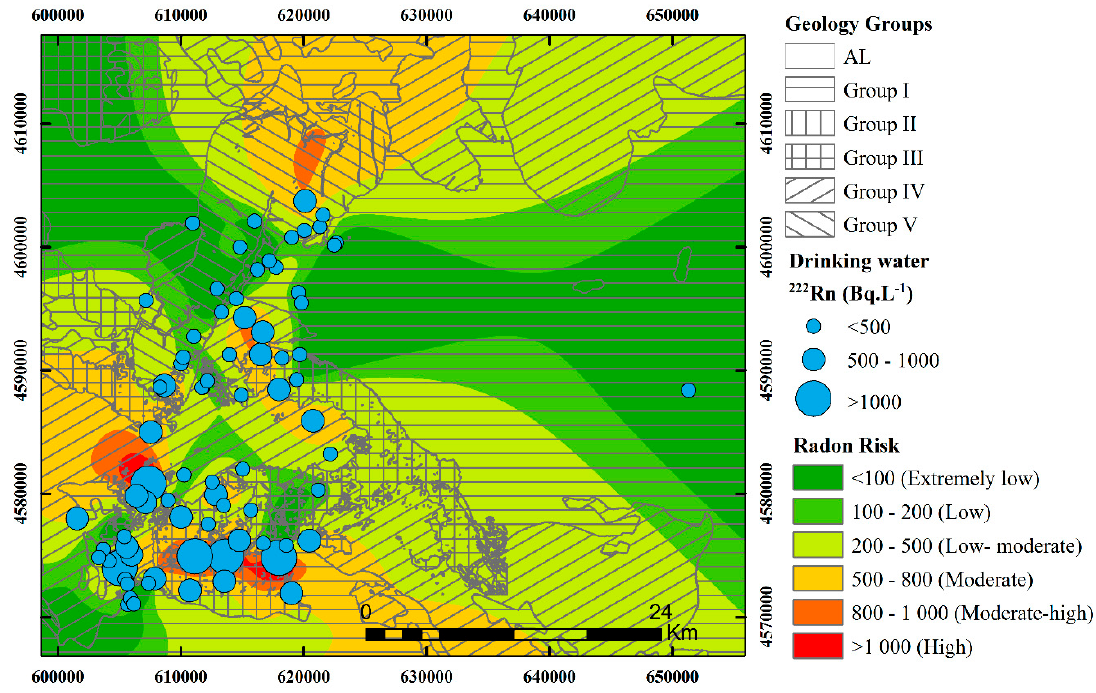
Figure 12. Radon risk map for drinking water supply with the projection of lithological groups and water collection points with graduated values.